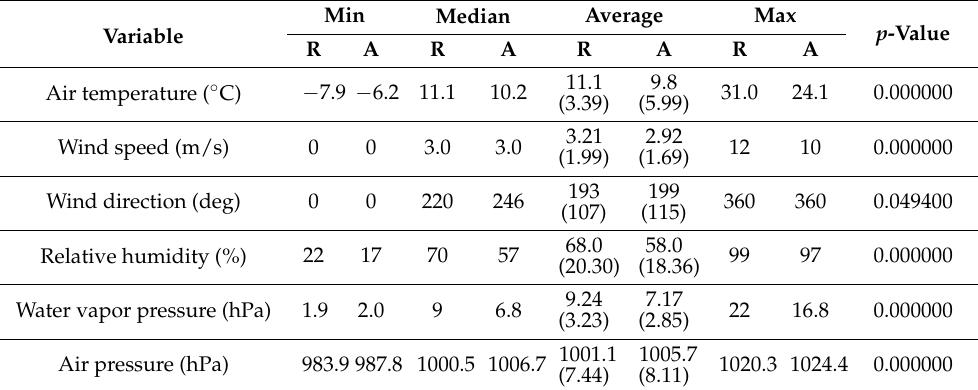
Table 2. Descriptive statistics for meteorological conditions during reference period R (10